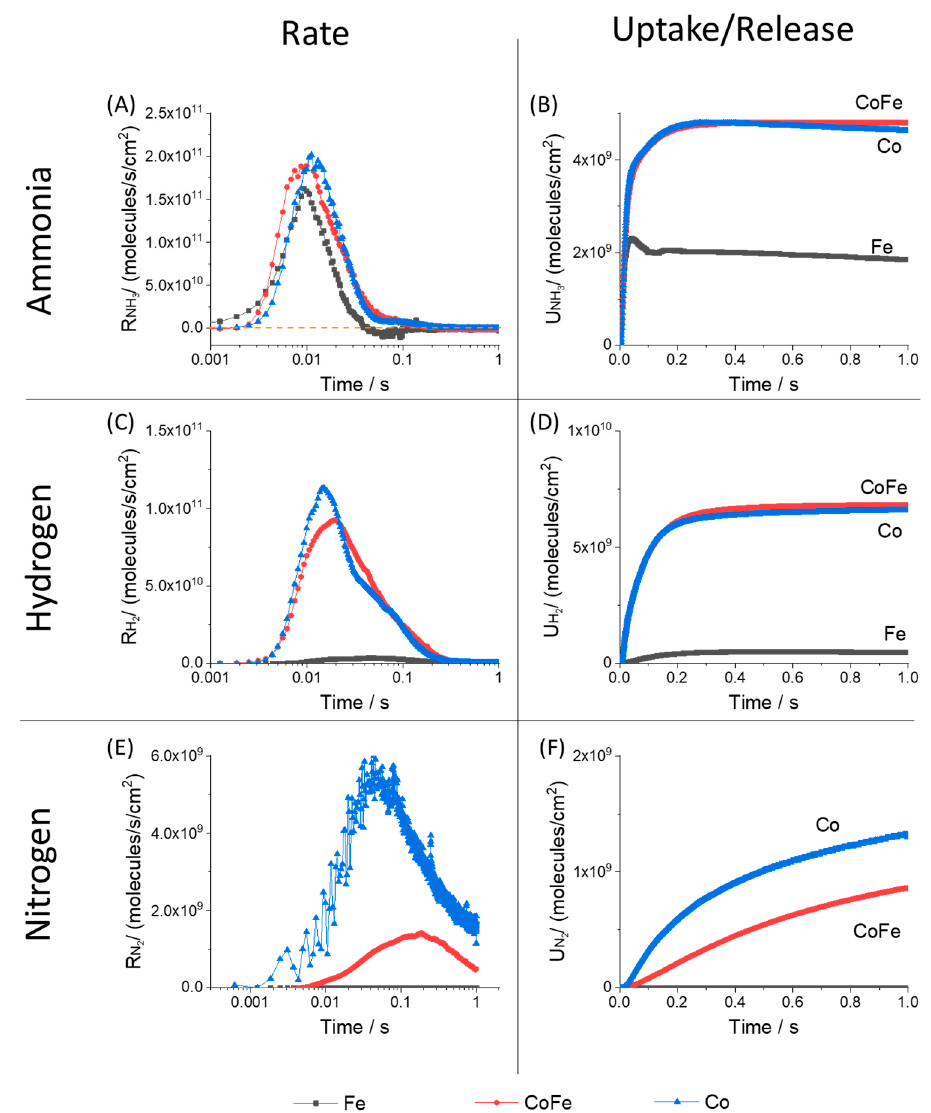
Figure 7. Molecular reaction rate calculated from pulse response data when ammonia is pulsed at 550 °C for ( A ) ammonia, ( C ) hydrogen and ( E ) nitrogen; catalyst uptake calculated from the integral of the rate for ( B ) ammonia; catalyst release calculated from the integral of the rate for ( D ) hydrogen and ( F ) nitrogen on different samples (Fe, CoFe and Co). Note: log-based time scale on rate data, linear time scale on uptake data.